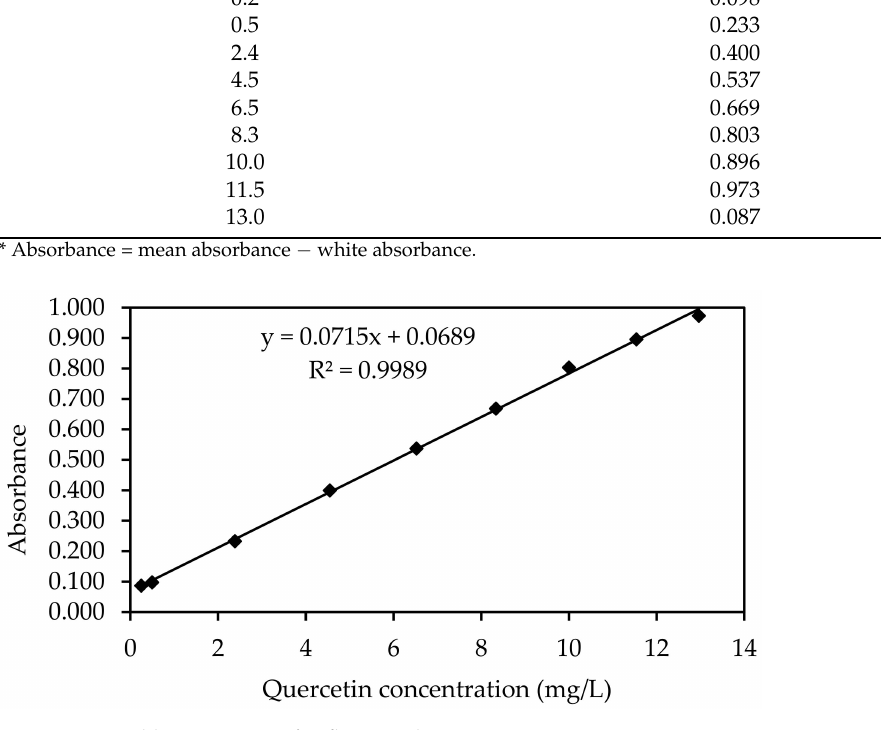
Figure A2. Calibration curve for flavonoids